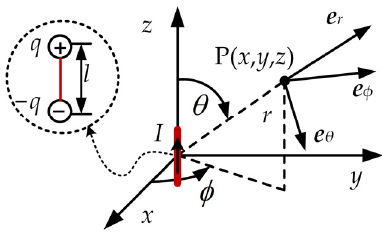
Figure 3. Schematic diagram of an electric